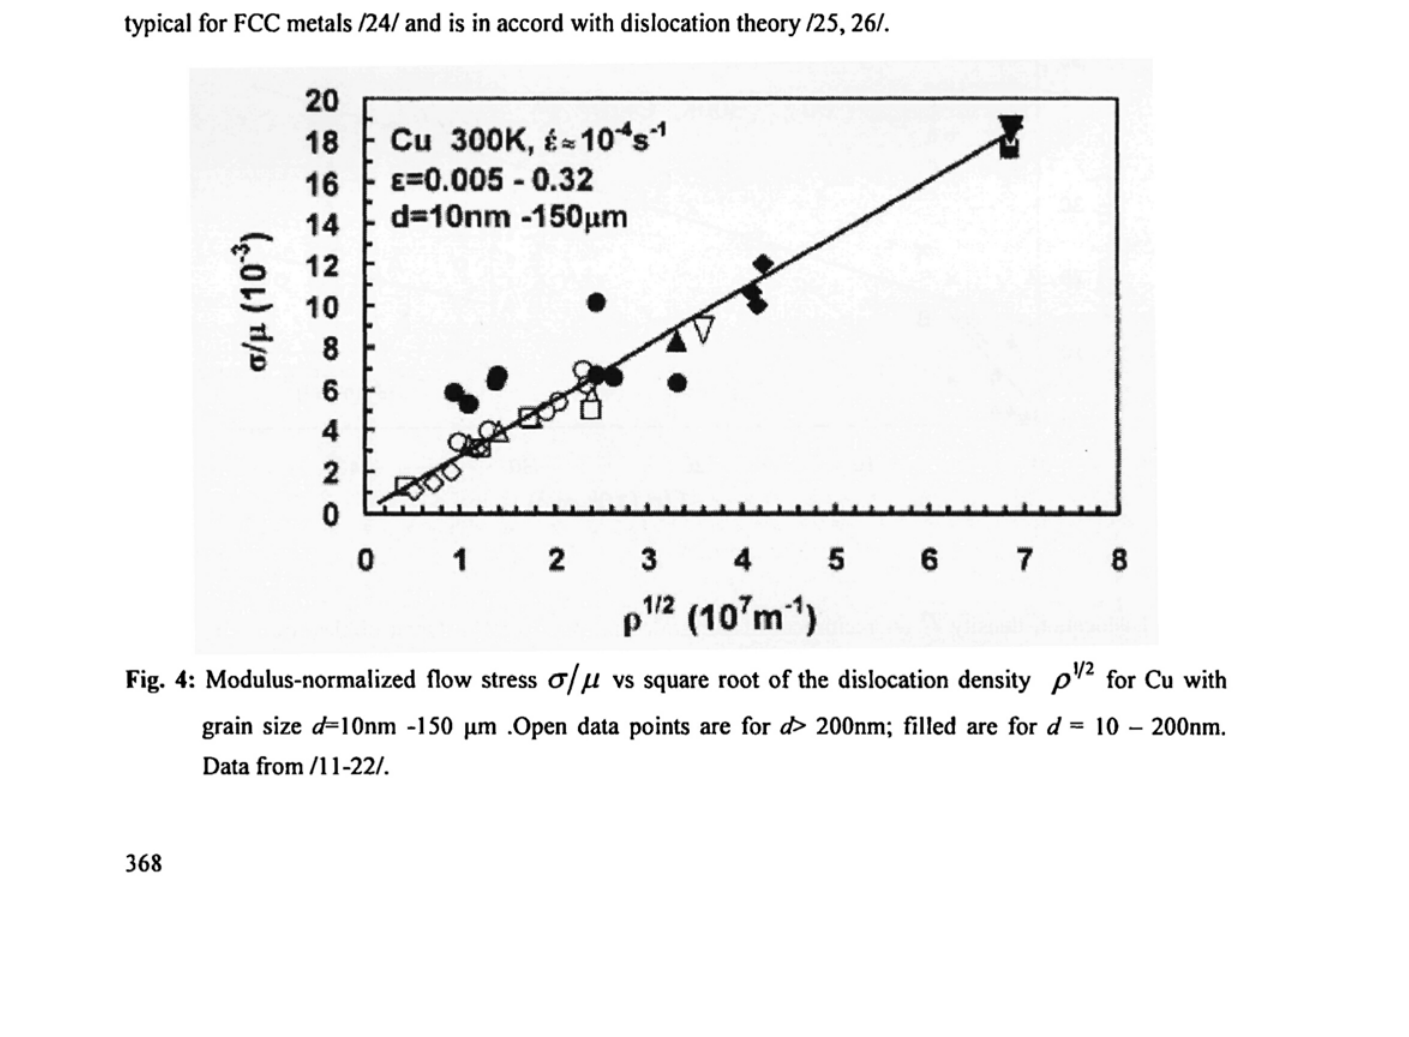
and β determined from Figure 3. t